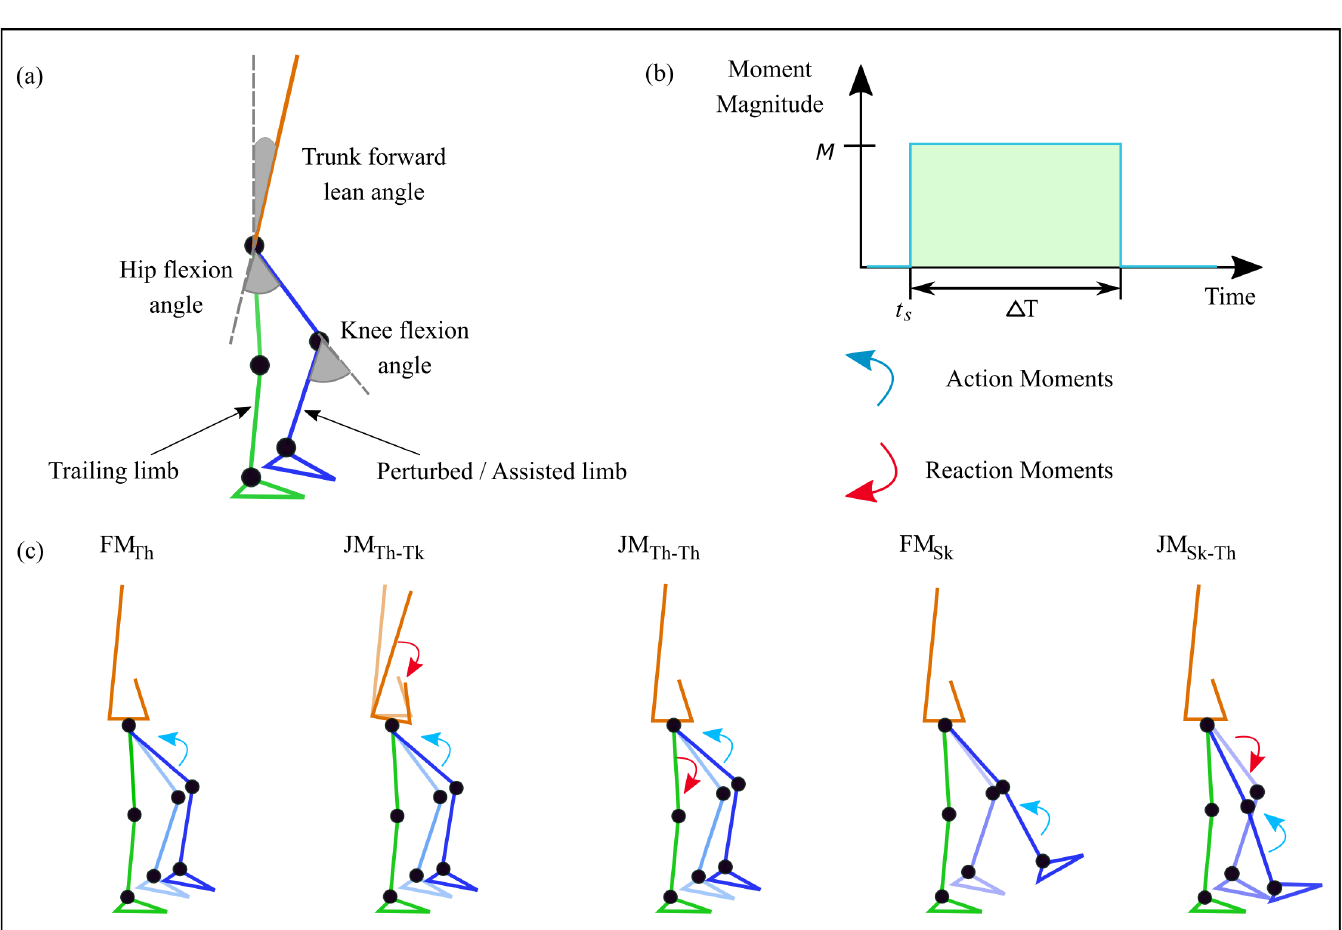
Fig 1. Actuator and joint angle definitions. (a) Definitions of joint angles of the sagittal-plane model. (b) The action moment is parametrised by its magnitude M , start time t , and duration Δ T. The reaction moments equal in magnitude and opposite in direction to the action moments are applied to an adjacent limb segment. (c) Effects s of the 5 different actuator types: free moment with action on thigh (FM Th ), joint moment with action on thigh and reaction on trunk (JM Th-Tk ), joint moment with action on thigh and reaction on contralateral thigh (JM Th-Th ), free moment with action on shank (FM Sk ), joint moment with action on shank and reaction on thigh (JMSk-Th).